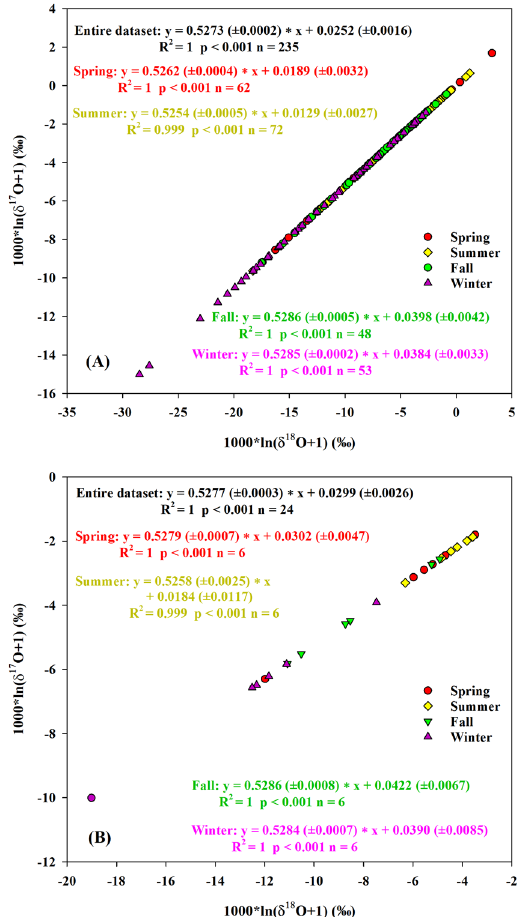
Figure 3. The relationships between δ 17 O and δ 18 O based on daily ( A ) and monthly ( B ) precipitation within different seasons between June 2014 and May